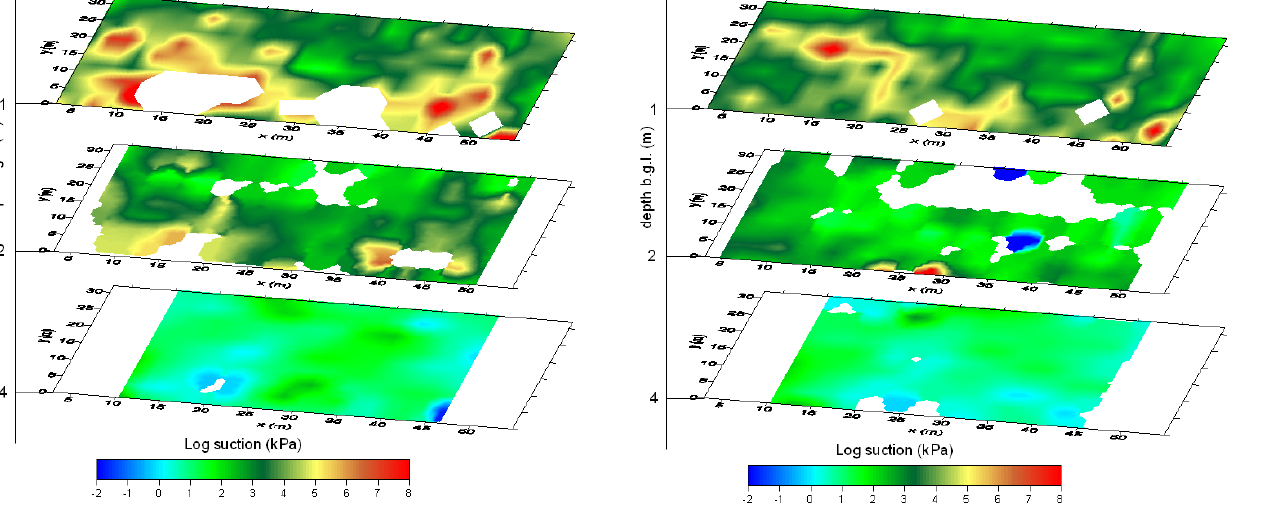
Fig. 8. Contour maps of soil suction obtained from Eqs. (4) and (5), where resistivities are derived from the autumn survey. White areas on the maps correspond to regions where Eqs. (4) and (5) are not defined, since ρ values from the in situ measurements describe water contents greater than θ s or less than θ r , as estimated by laboratory analyses for each type of soil.